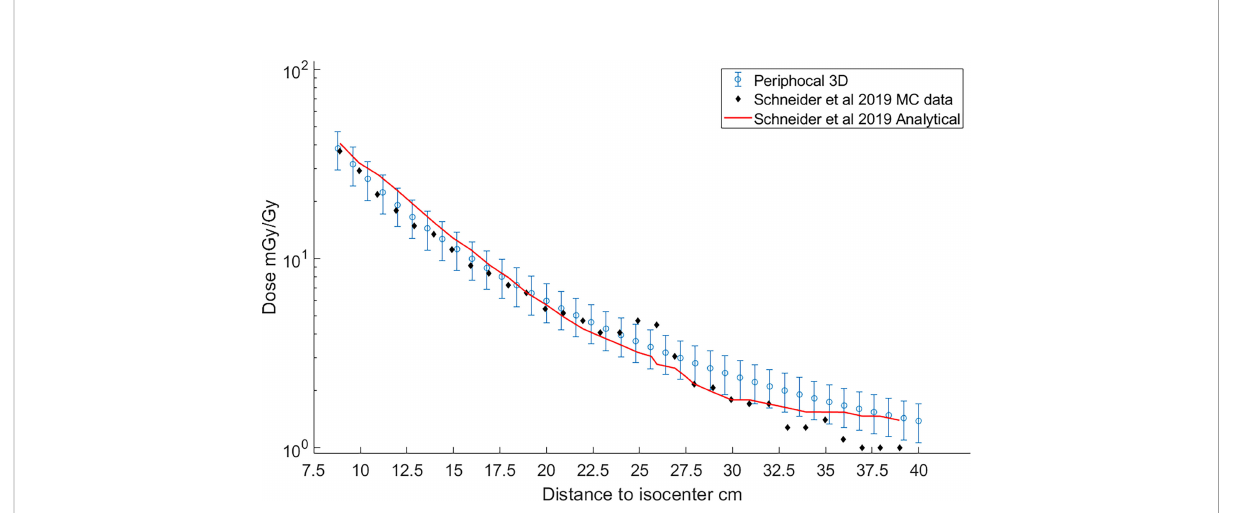
FIGURE 8 Comparison of the peripheral dose calculated with Periphocal 3D (light-blue open symbols with uncertainty bars) and Schneider et al. (22) model (solid line). Schneider model´s data were recreated from fi gure 14.a of the publication (22). Additionally, the MC data used to fi t the 30 parameters of the peripheral dose of Schneider´s model — table 4 in Schneider et al. (22) — are also included as black